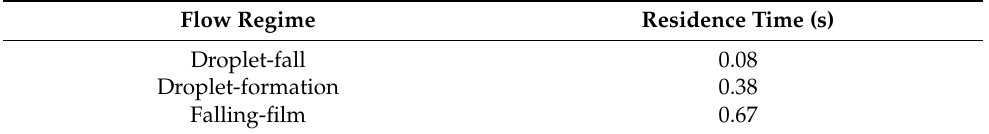
Table 3. Average residence time for each flow regime in the horizontal tube falling-film absorber using aqueous alkaline nitrate solution as a working fluid.